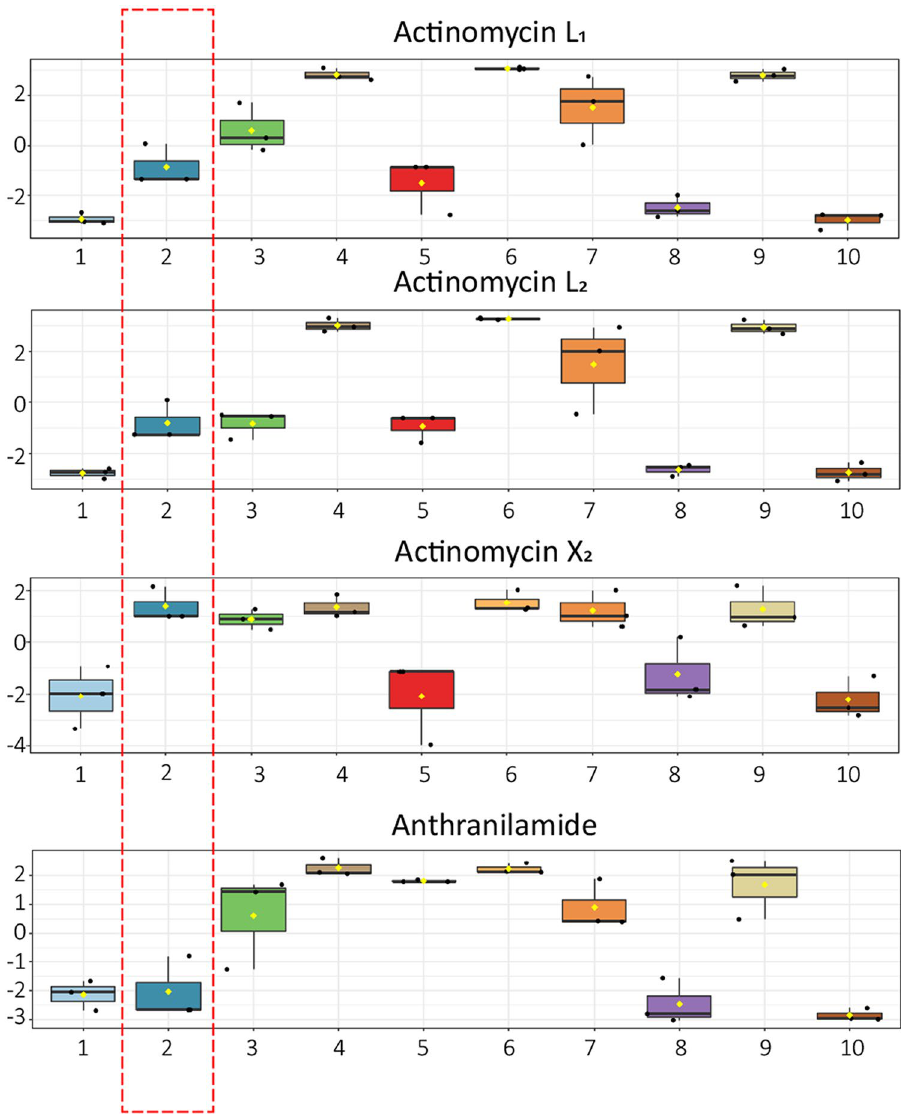
Figure 5. Box plots showing the relative intensities of actinomycin L 1 , L 2 and X 2 and anthranilamide after log transformation and pareto scaling. Cultures of Streptomyces sp. MBT27 were grown for 7 days in MM with the following carbon sources: 1. 1% arabinose; 2. 1% fructose; 3. 1% GlcNAc; 4. 1% glucose; 5. 2% glucose; 6. 1% glycerol; 7. 2% glycerol; 8. 1% mannitol; 9. 1% mannitol + 1% glycerol; 10. 2% mannitol (% ages in w/v). Red box indicates the abundance of actinomycin L 1 , L 2 and X 2 and anthranilamide in the cultures grown with fructose (1% w/v). Note that Streptomyces sp. MBT27 produced actinomycin L and anthranilamide in very low amounts when fermented with fructose (1% w/v) as the sole carbon